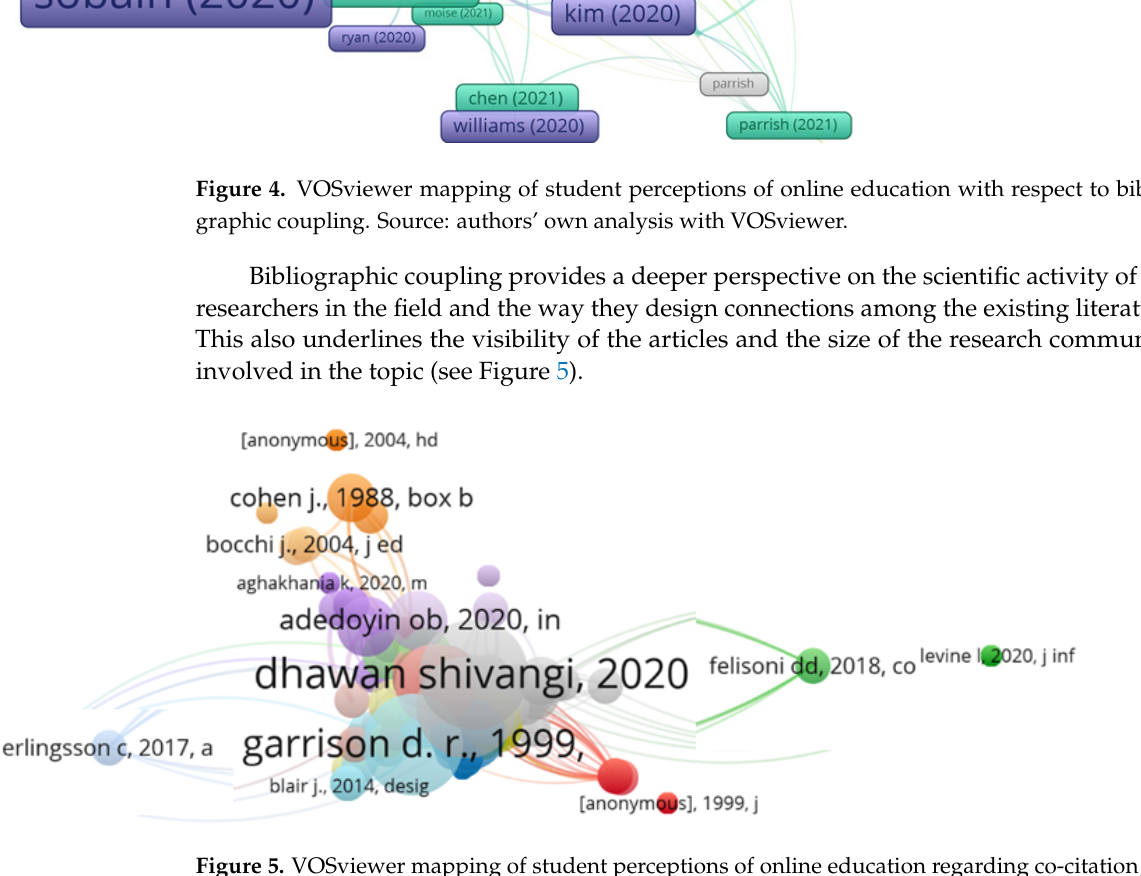
Figure 6. VOSviewer mapping of student perceptions of online education with respect to co-occur- rence. Source: authors’ own analysis with VOSviewer. The co-occurrence matrix is based on the most frequently used keywords by re- searchers in the field revealing the main topics of interest defining the investigated frame- work. 3.4. Summarizing the Evidence and Interpreting the Findings This systematic review builds upon scientific articles written in English between 2020 and 2022 addressing student perceptions of online education. Our review of 154 articles retrieved from the Scopus and Web of Science databases concentrated mostly on the pos- itive/negative as well as neutral student perceptions with limited attention given to teacher and/or other higher education stakeholders perspectives. Using the filters ‘stu- dents’ perceptions’ and ‘online education’, 123 scientific articles were identified in Scopus and 72 in WoS. After merging the two databases, 41 duplicates were removed, and the output consisted of 154 scientific articles in English.